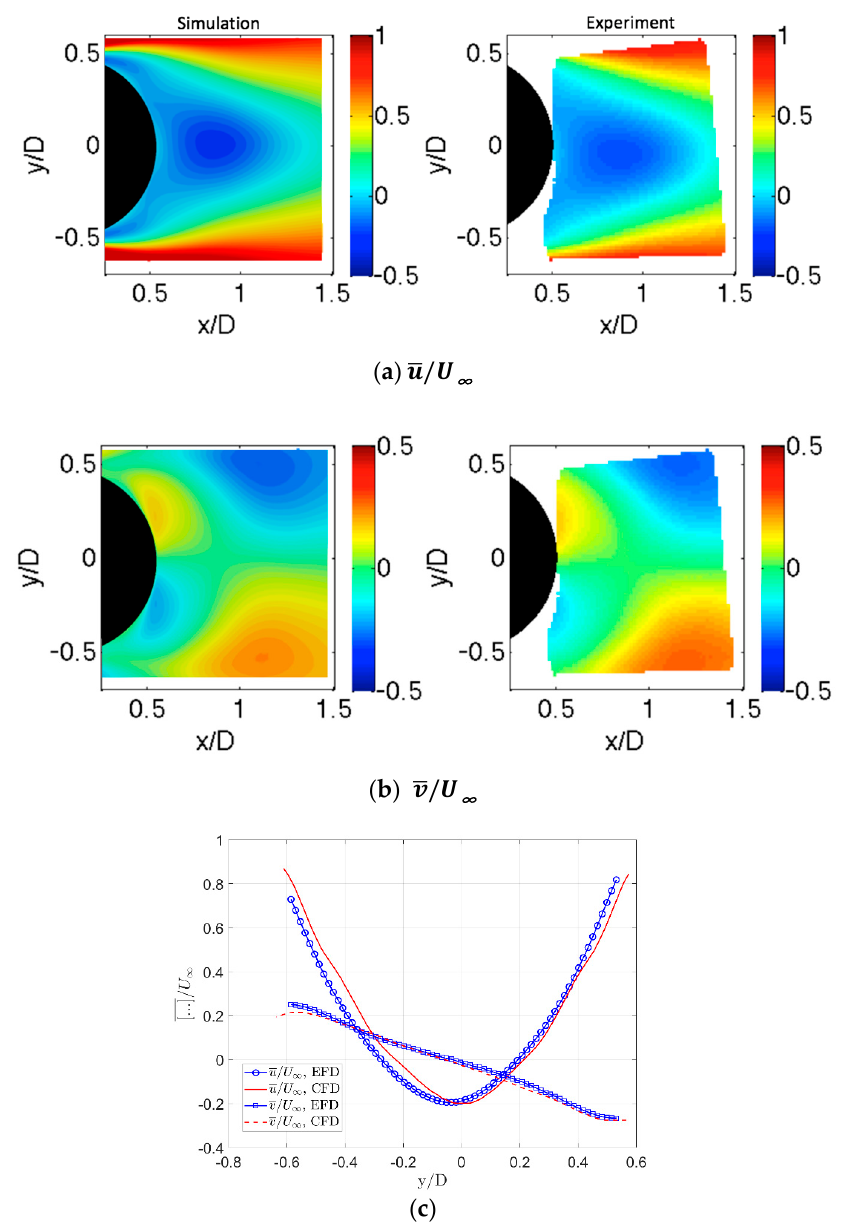
Figure 12. Mean velocity components in cylinder wake. ( a ) contours of streamwise velocity; ( b ) Figure12. Meanvelocitycomponentsincylinderwake. ( a )contoursofstreamwisevelocity; ( b ) contours contours of transverse velocity; ( c ) EFD/CFD line plot comparisons at 𝑥/𝐷 = 1. of transverse velocity; ( c ) EFD / CFD line plot comparisons at x / D =